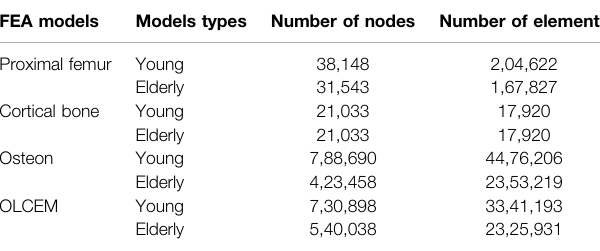
TABLE 1 | Detailed element parameters of multiscale FE models. TABLE 2 | Density – elasticity relationships used to determine the orthotropic